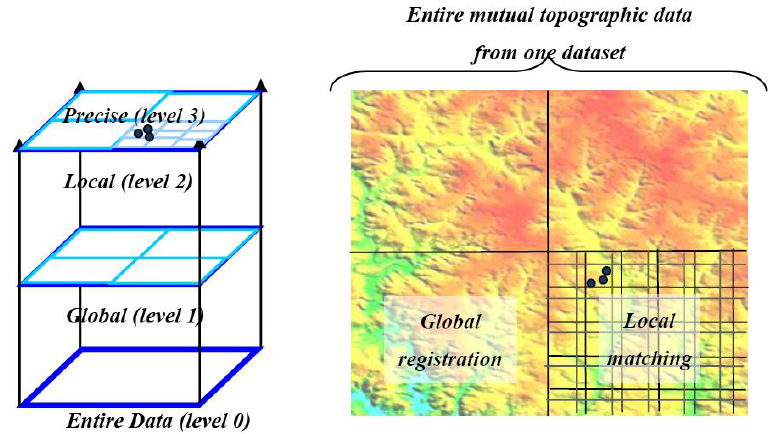
Figure 3. Hierarchical modelling schema, depicting three-working levels: global (registration, level 1), local (matching, level 2) and precise position-derived data-integration and interpolation (level 3).